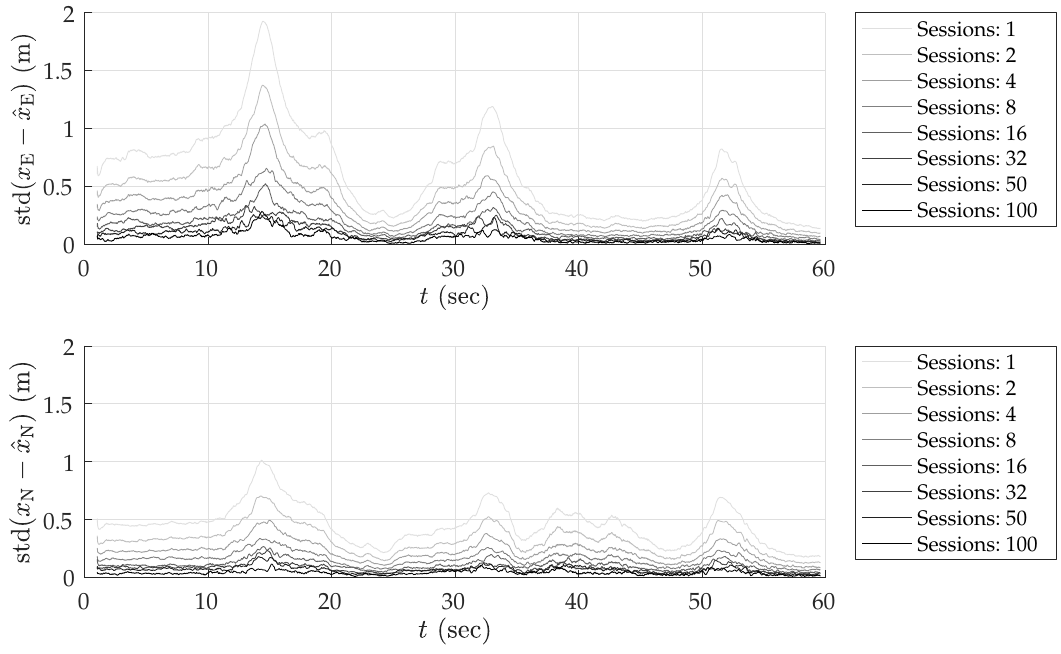
Figure 6. Standard deviation of average position error in east and north directions for NIS-based multipath exclusion as a function of the number of sessions over which the errors are averaged. Top panel : standard deviation in the east direction. Bottom panel : standard deviation in the north